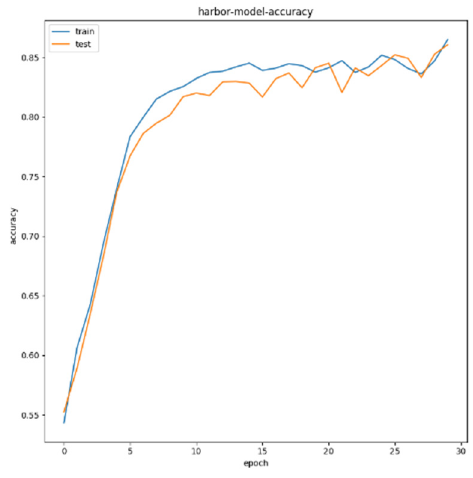
Figure 23. Accuracy of port target recognition.